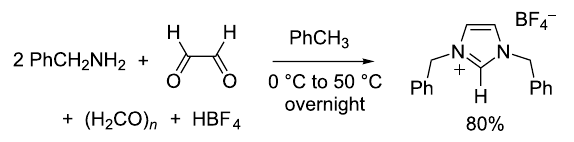
ciated counterion (chloride or tetrafluoroborate), or the steric bulk of their nitrogen substituents (ranging from small,